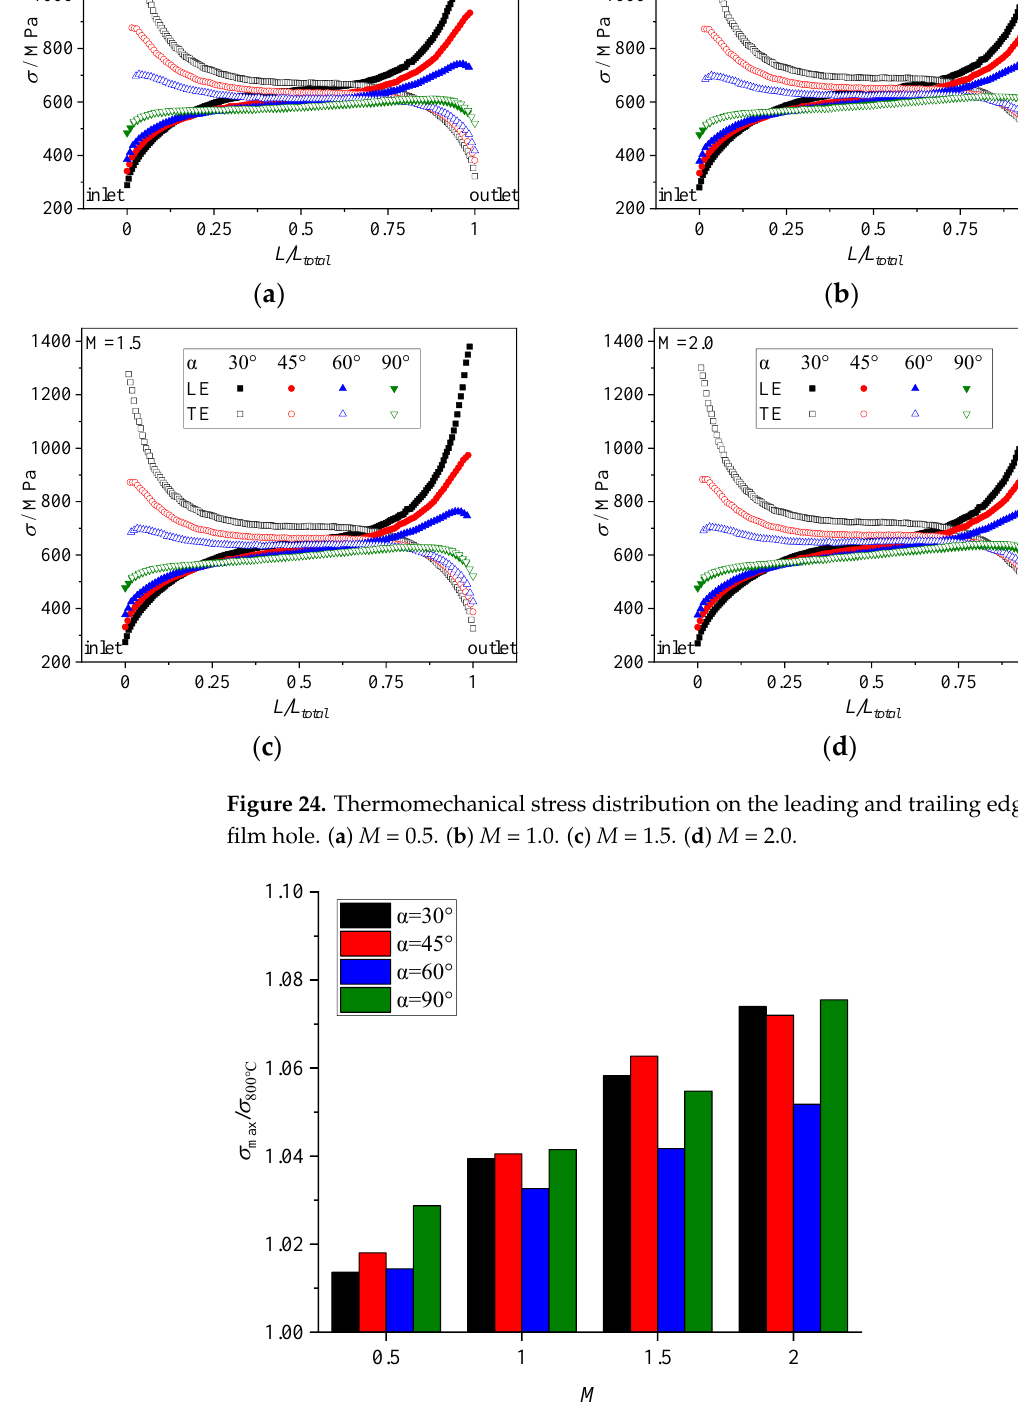
Figure 25. Ratios of maximum thermomechanical stress of research film hole to the stress under 800 °C for all cases. 4. Conclusions This study conducted a fluid – thermal-structure coupling analysis of an impinge- ment/effusion cooling system. The novelty of the current paper in comparison with the previous works is that the cooling characteristics and stress characteristics of the impinge- ment/effusion cooling system were simultaneously studied to evaluate the cooling sys- tem ’s performance more comprehensively. A conjugate heat transfer analysis was